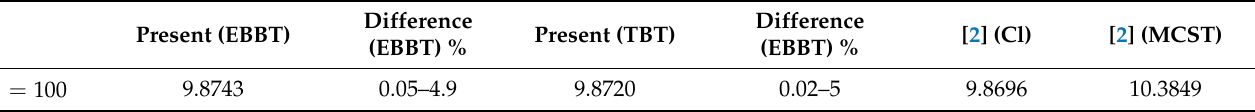
Table 2. Comparison of dimensionless